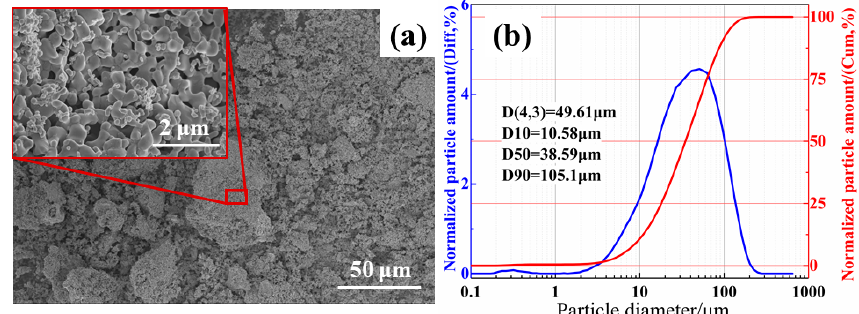
Figure 8. SEM photo ( a ) and particle size distribution ( b ) of the deep reduction product (leached).